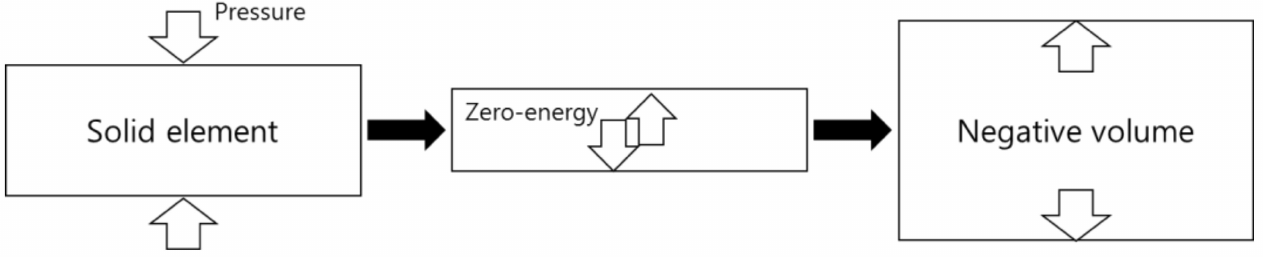
Figure 2. Process of the negative